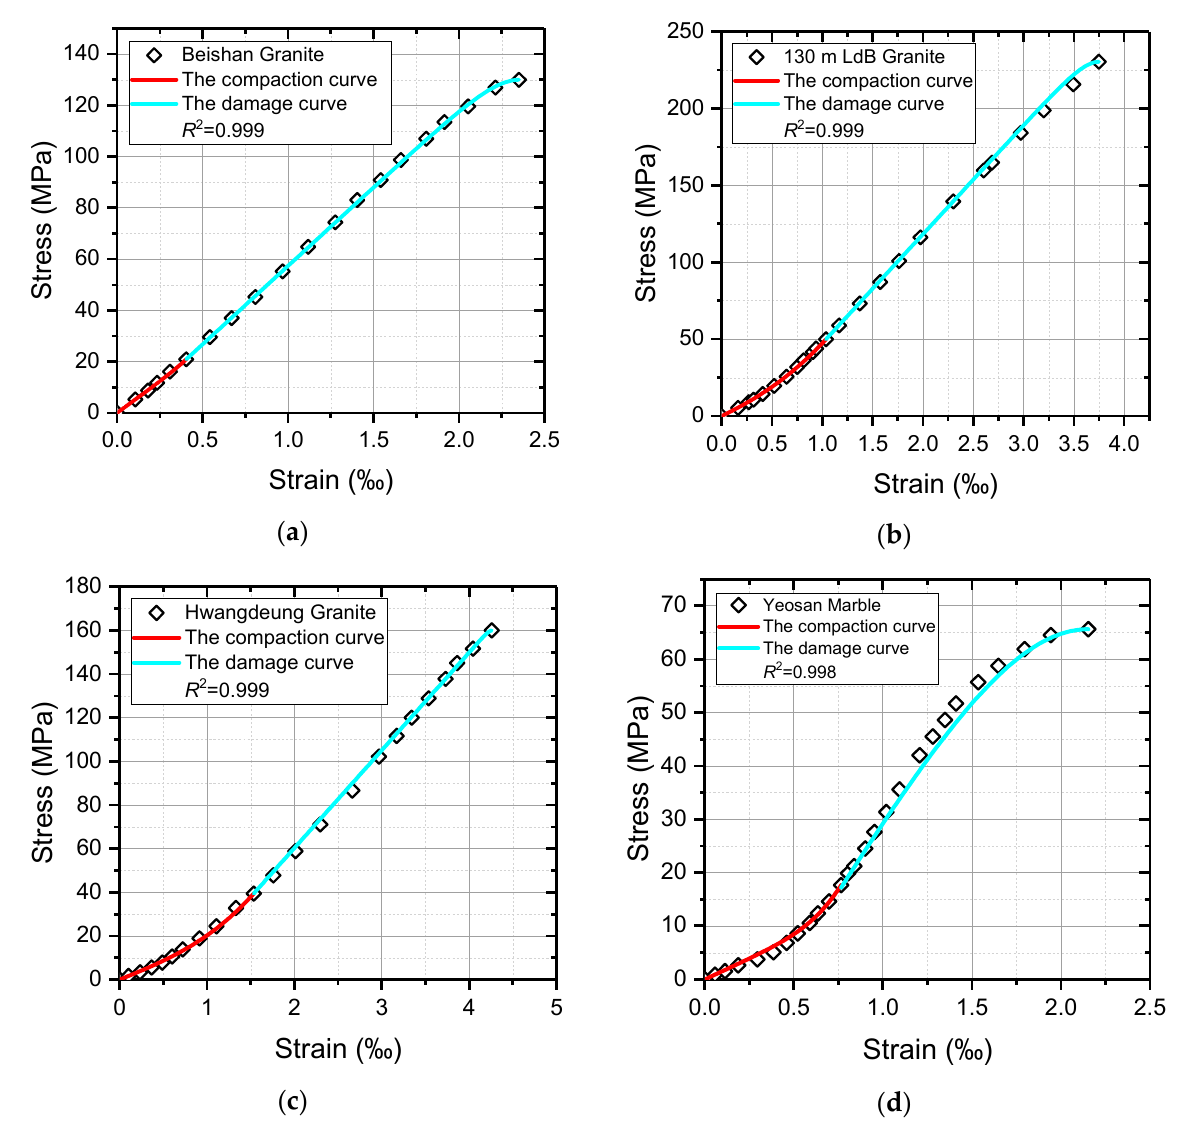
Figure 9. The comparison between uniaxial test data and model curves of various rocks. ( a ) Beishan Granite; ( b ) 130 m LdB Granite; ( c ) Hwangdeung Granite; ( d ) Yeosan Marble. Table 1. Model parameters for uniaxial tests.